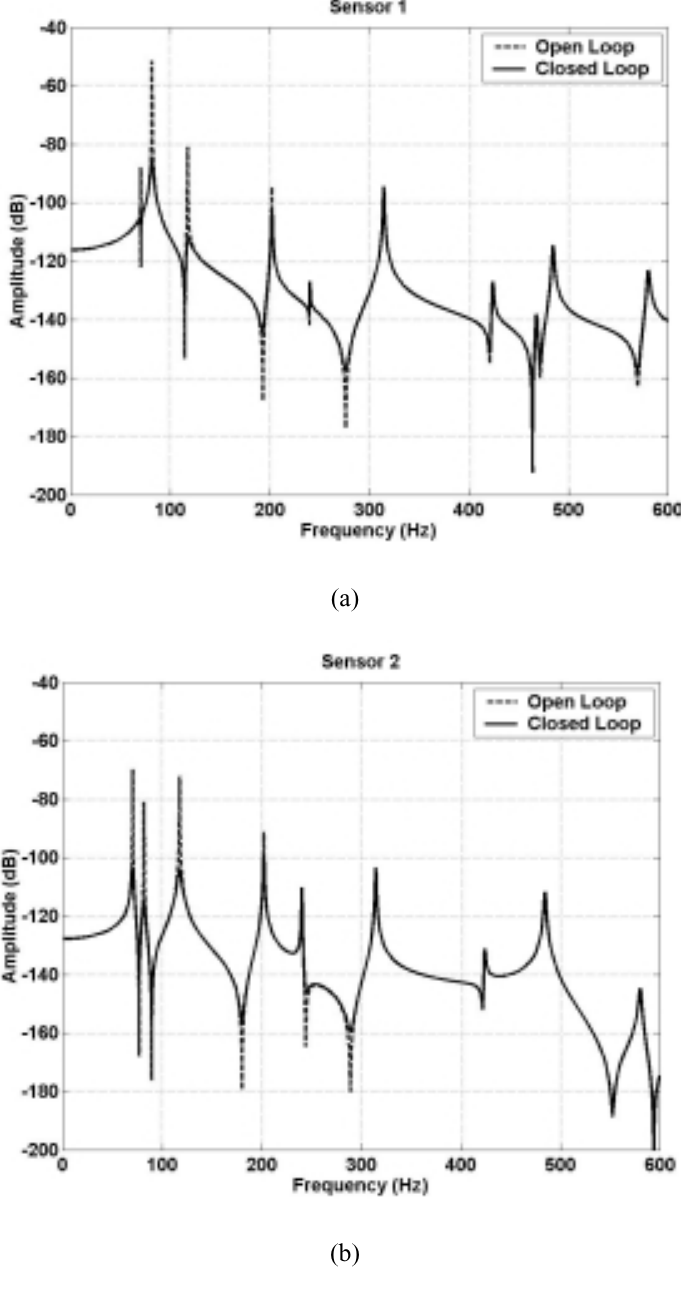
Fig. 9. Spectra of the uncontrolled and controlled system at (a) sensor 1 and (b) sensor 2 when the EMC strategy is